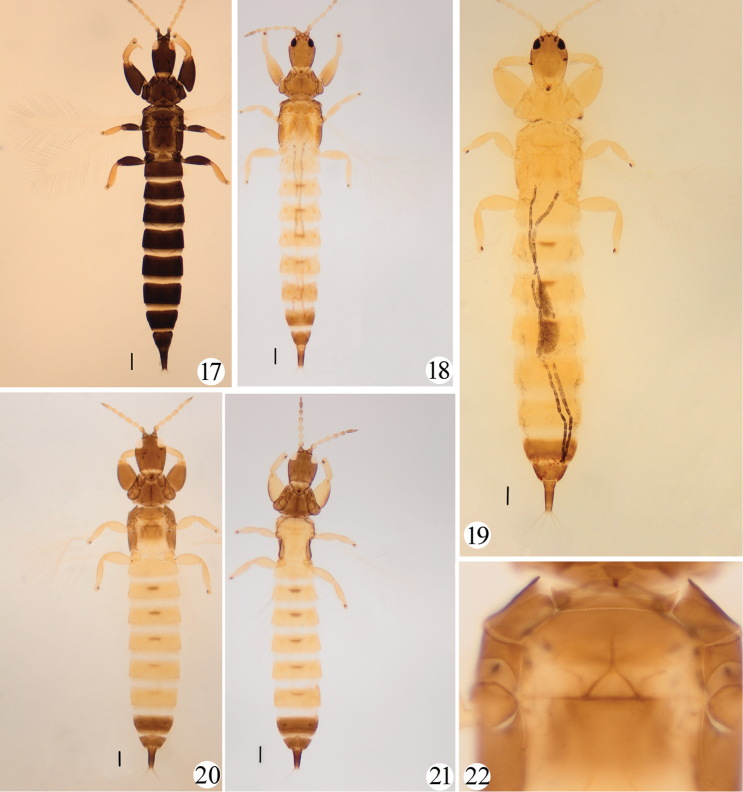
Podothrips adult colour patterns 17P.
lucasseni18P.
odonaspicola19P.
semiflavus20P.
femoralis sp. nov. 21P.
sasacola. Some important features of femoralis sp. nov. 22 mesopresternum and metathoracic sternopleural sutures. Scale bars: 200 microns.